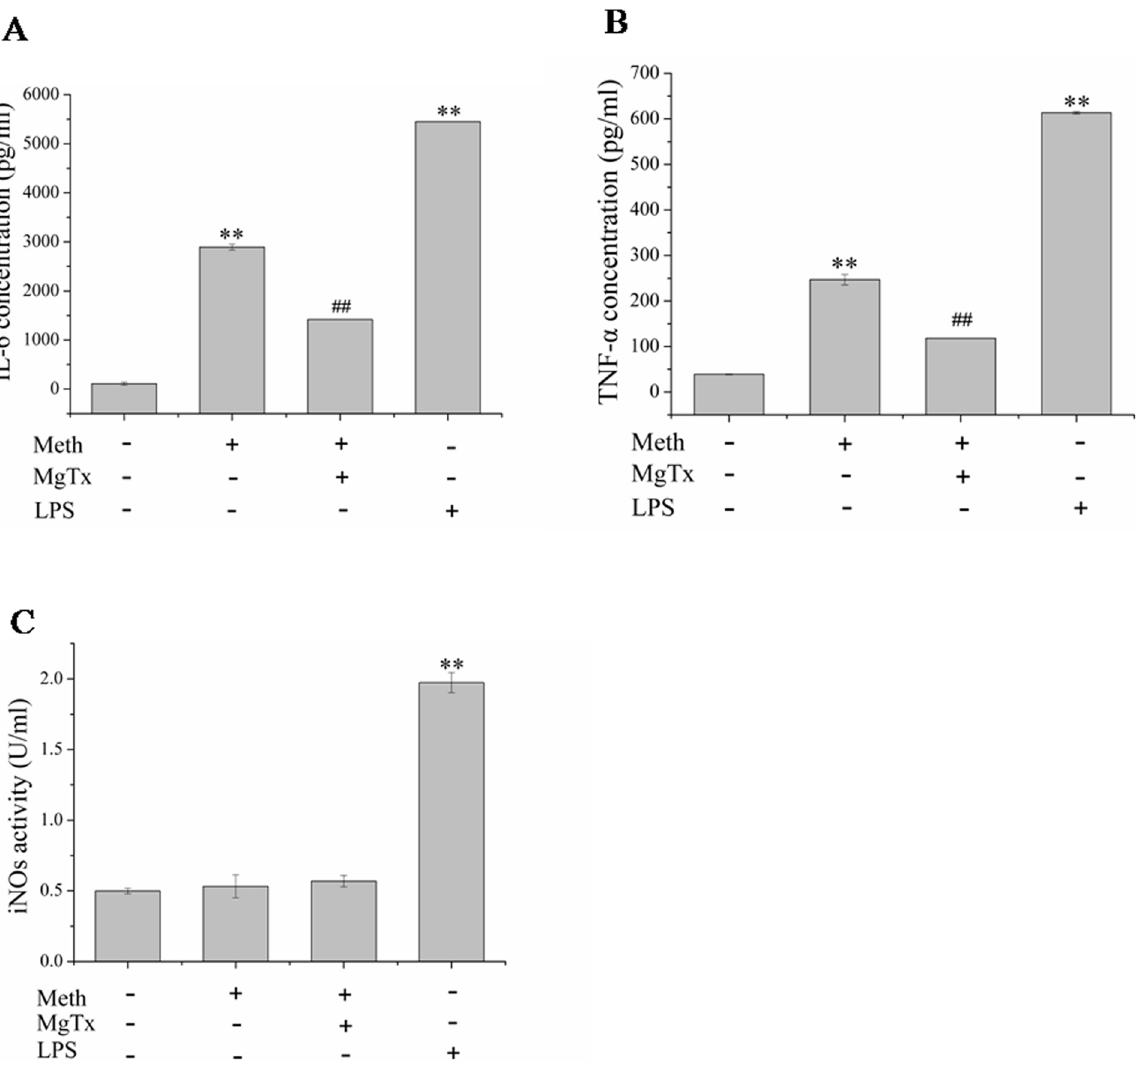
Figure 7. Effects of Meth on cytokines (IL-6, TNF- a and iNOS) secretion. (A, B) Meth markedly increased IL-6 and TNF- a secretion, while MgTx obviously inhibited IL-6 and TNF- a releasing mediated by Meth. (C) Meth exerted no obviously effect on iNOS activity. Each data point represents mean 6 SD of mRNA levels from at least three separate experiments in which treatments were performed in triplicates.* and # indicate significant differences compared with the control and condition stimulated by Meth respectively (p , 0.05 by